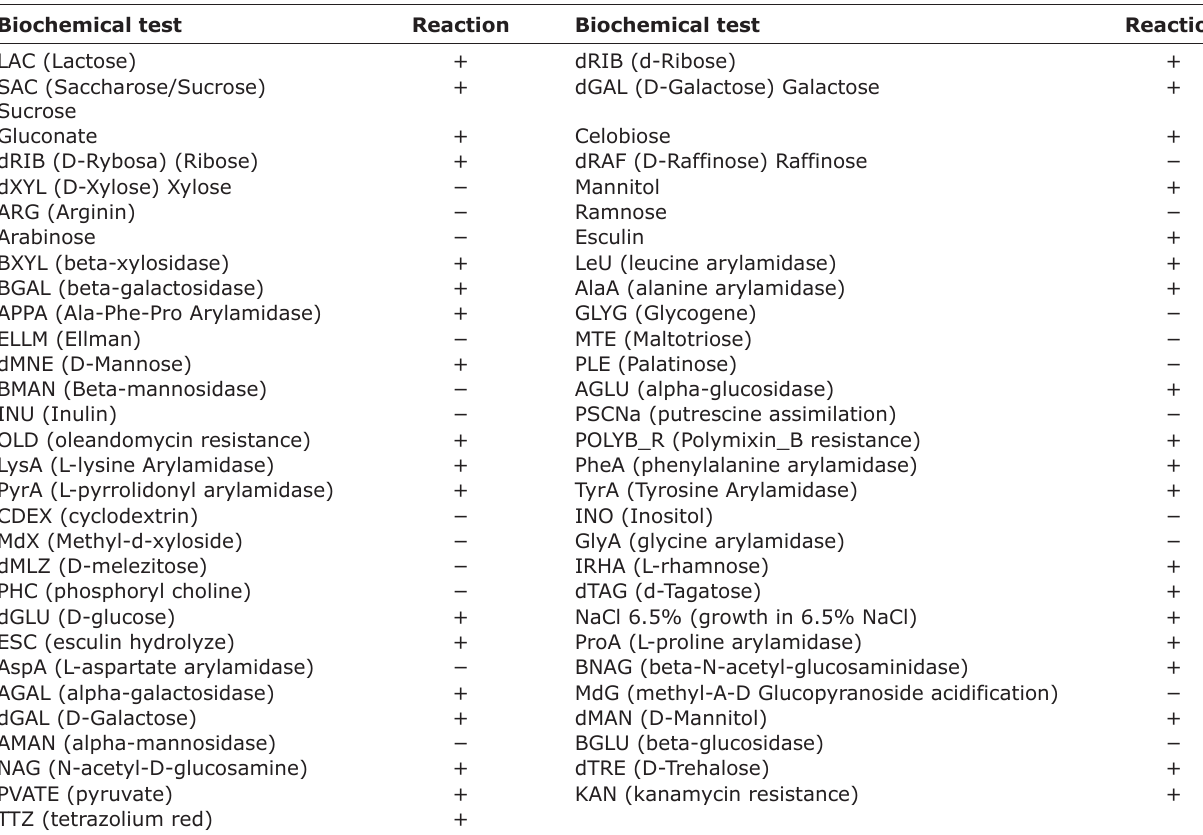
Table-2: Biochemical test of LAB isolate WPL 315 by VITEK 2 Biochemical test